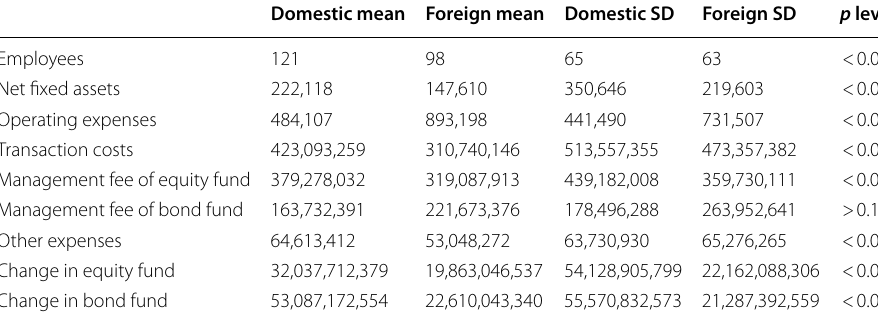
Table 5 Kolmogorov–Smirnov test of differences between foreign and domestic